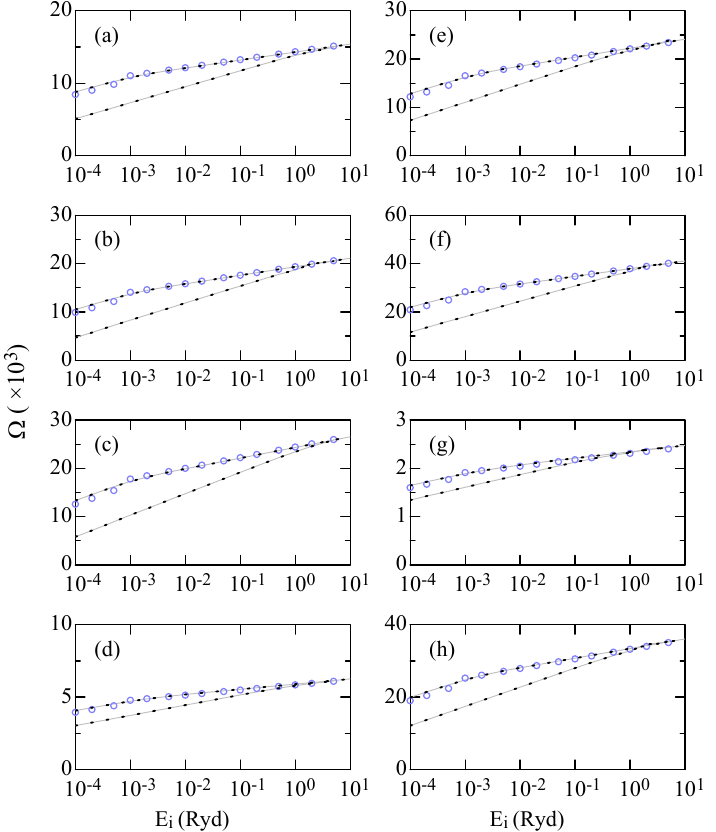
Figure 6. Variation of Ω with energy E i for the transitions within n = 4: ( a ) 4p 1/2 –4s 1/2 ; ( b ) 4p 1/2 –4d 3/2 ; ( c ) 4s 1/2 –4p 3/2 ; ( d ) 4d 3/2 –4p 3/2 ; ( e ) 4d 3/2 –4f 5/2 ; ( f ) 4p 3/2 –4d 5/2 ; ( g ) 4f 5/2 –4d 5/2 ; and ( h ) 4d 5/2 –4f 7/2 . Upper and lower curves are for Born and CC+Born collision strengths for H (continuous curves) and D (dots). Circles on upper curves are Bethe–Born results for